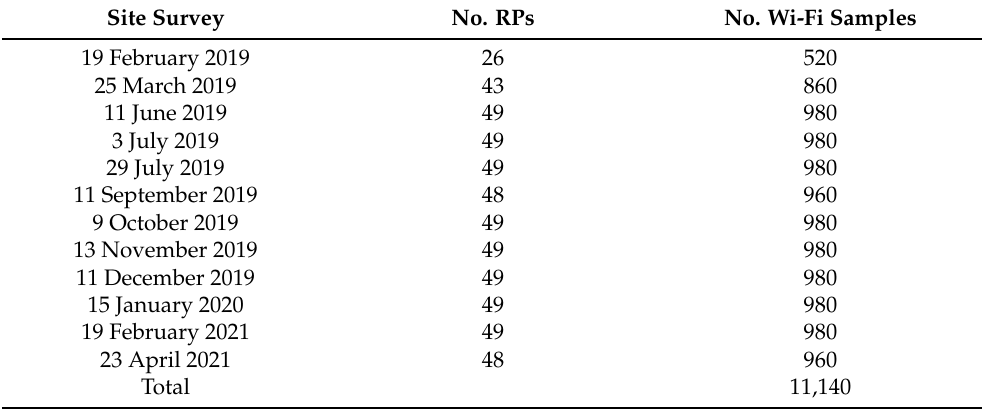
Table 2. Manually surveyed Reference Points and number of collected Wi-Fi samples for each site